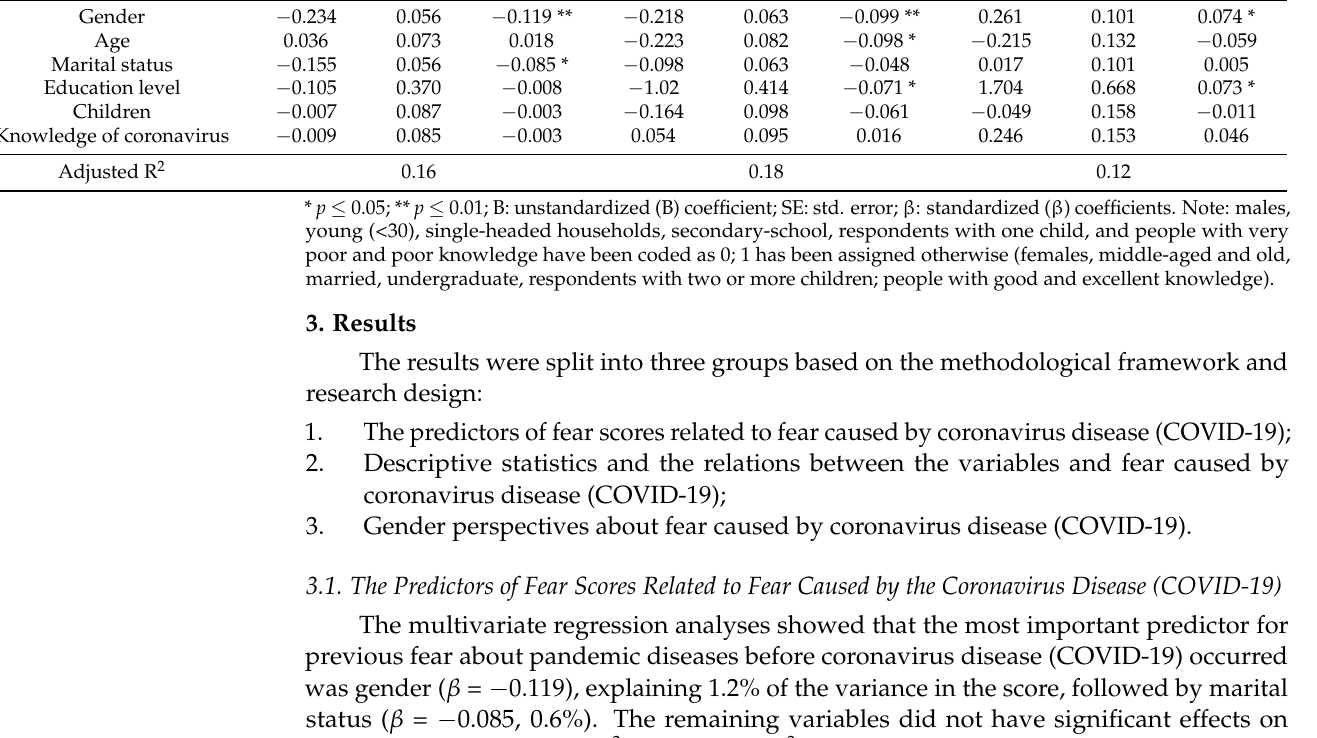
Table 2. Results of multivariate regression analysis concerning fear for coronavirus disease ( n = 1226). Previous Fear Fear About COVID-19 Recover of Predictor Variable